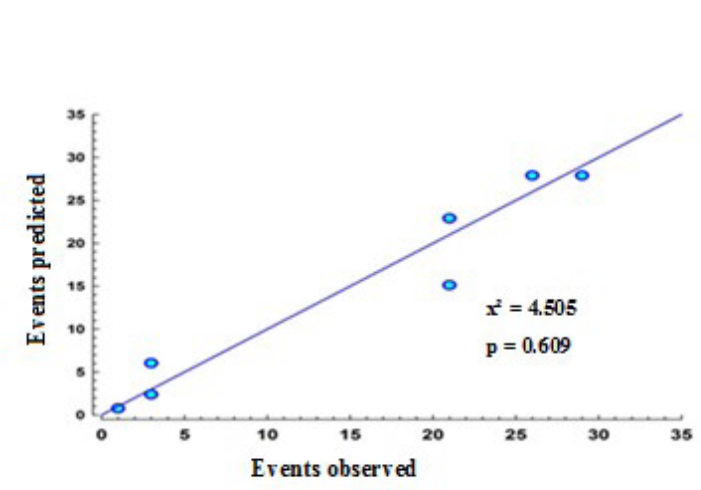
Fig. 3 – Distribution of points representing the outcome (stroke) as predicted by the logistic model and observed in the patient